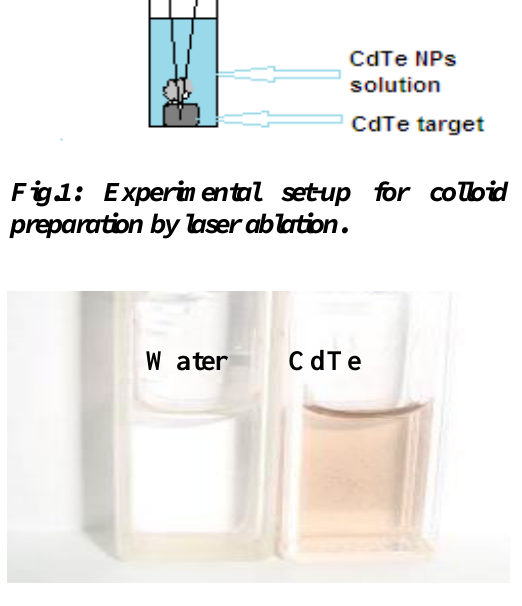
Fig.2: Photograph of colloidal CdTe